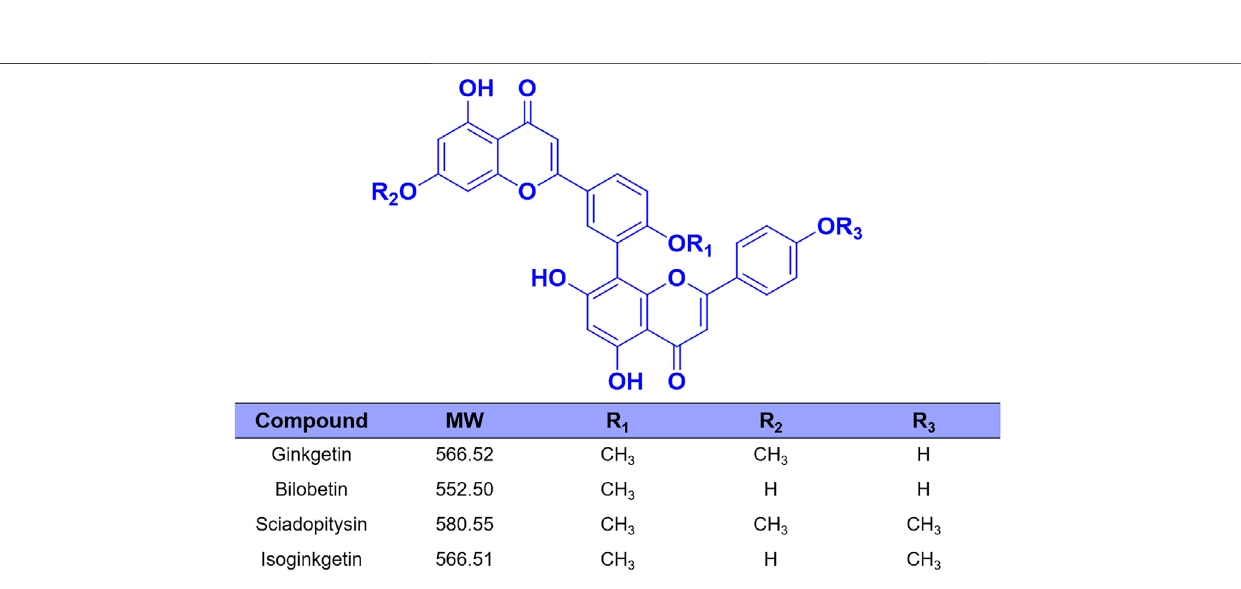
Frontiers in Pharmacology |